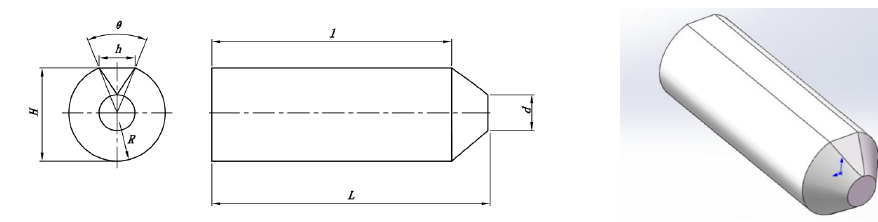
Figure 3. Structure of the pontoon.